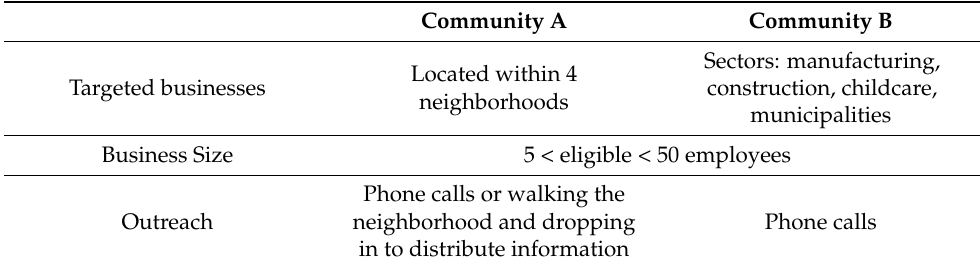
Table 3. Eligibility and outreach strategies for two